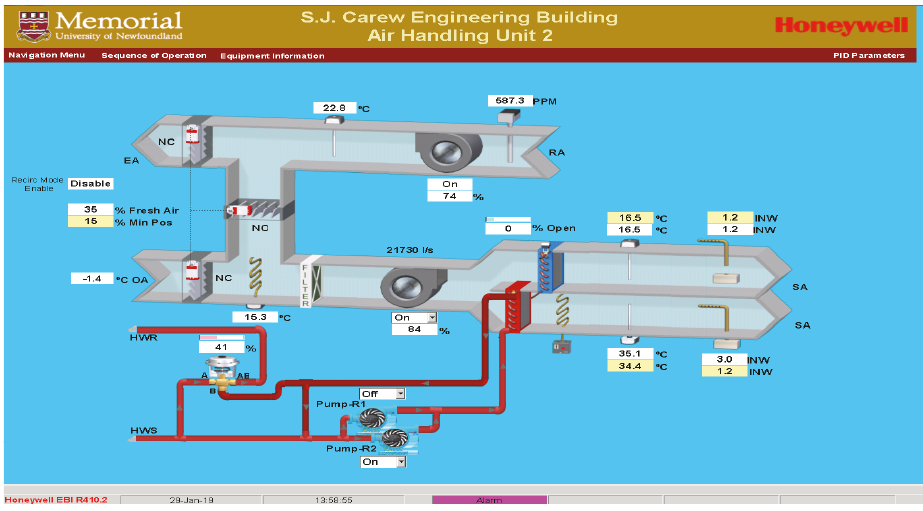
Figure 2: AHU 2 for S. J. Carew